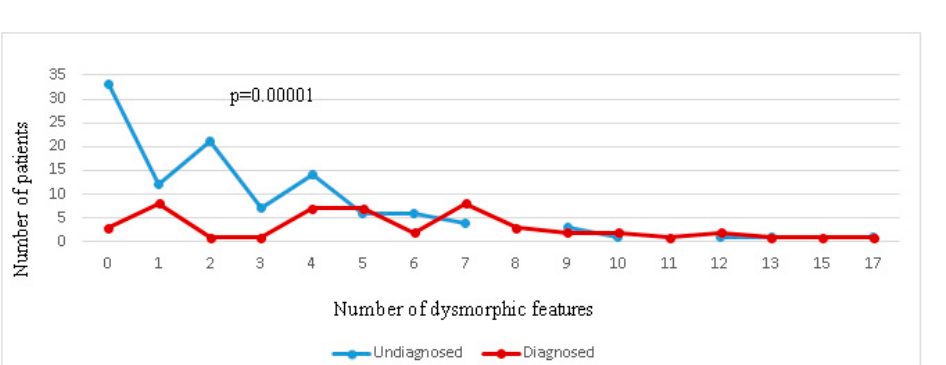
Figure 2. Distribution of patients with different numbers of dysmorphic features in groups with and without a molecularly confirmed diagnosis.